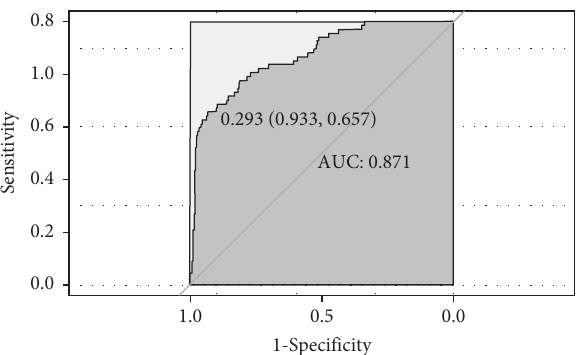
Figure 4: ROC curve for month